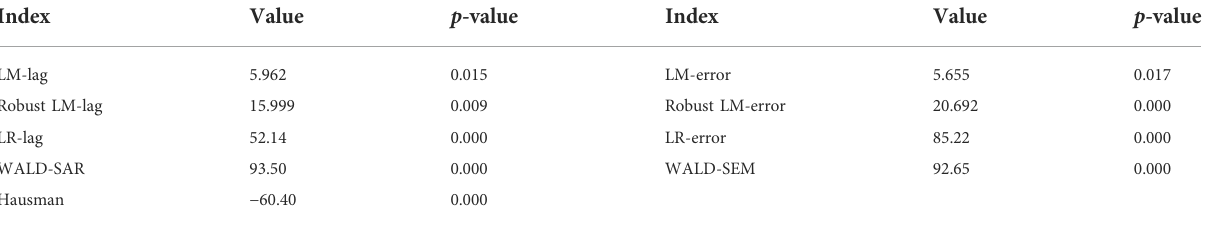
TABLE 3 Test results of the model